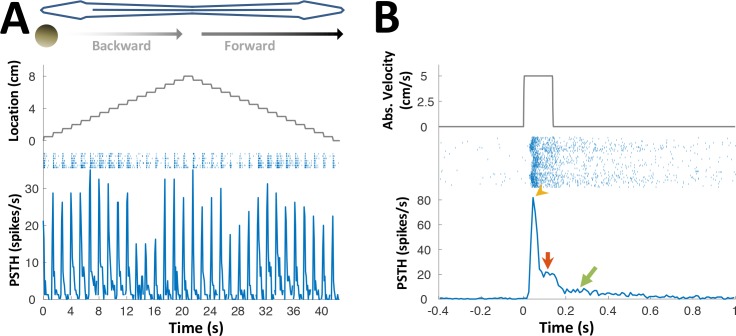
PG lateral-line responses.Response of an example PG cell to longitudinal motion of an agar sphere (15% agarose dissolved in tank water). The sphere’s conductivity was identical to that of the surrounding water, making it electrically invisible (Heiligenberg, 1973). Acoustic stimuli were also delivered to exclude the possibility of an auditory response. The relatively small number of lateral-line sensitive cells found (N = 7) precludes systematic characterization of the response properties of these cells. (A) Motion in each direction was broken into 16 segments separated by wait period (similar to Figure 3C). The cell responded to this motion in either direction, anywhere across the body surface. Since the object was electrically invisible, these responses likely reflect activation of the lateral-line system, which was shown to project to PG (Giassi et al., 2012a). (B) Cell response, averaged across body locations. Top: absolute velocity (cm/s); middle: spike raster plot; bottom: PSTH. Note that unlike most electrosensory PG cells (see Figure 3), this cell displayed not only motion onset response (yellow arrowhead), but also a response to continuous motion (red arrow) and prolonged response after motion cessation (green arrow; this post-stimulus discharge likely reflects wave reverberations in the experimental tank). This continuous response mode suggests that lateral-line related activity in PG conveys swimming velocity information, which can then be combined in the pallium (DL) with the time-interval information reported here to produce allocentric distance estimation between objects.